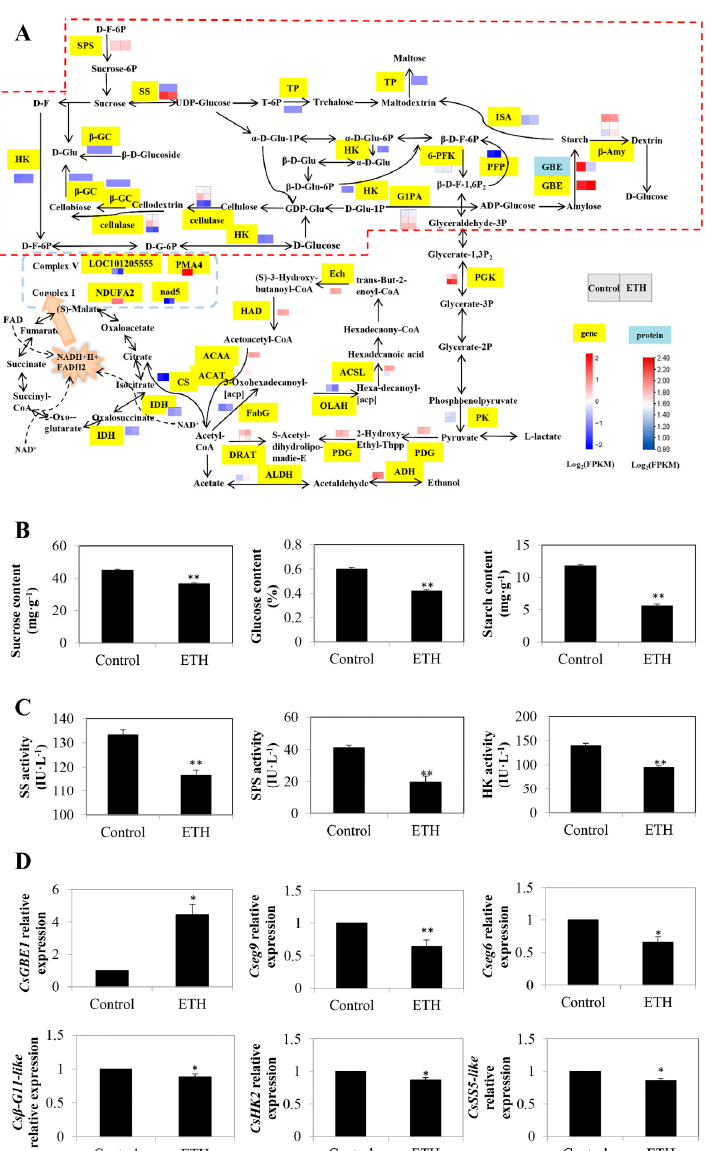
Figure 2. Identification and validation of key DEGs in starch and sucrose metabolism during adventitious root development in cucumber. ( A ) Expression patterns of genes and proteins for starch and sucrose metabolism in carbon metabolism during adventitious root development in cucumber. The dashed box represents starch and sucrose metabolism. Annotations of genes and proteins are available in Supplementary Table S5. Black characters with yellow background are genes, whereas black characters with blue background are proteins. The two squares under the names of genes or proteins indicate the abundance change between the control and ETH. A red square means up- regulation, whereas a blue square means down-regulation. ( B ) The contents of sucrose, glucose and starch during adventitious root development in cucumber. ( C ) The activities of SS, SPS and HK enzyme during adventitious root development in cucumber. ( D ) Quantitative real-time PCR analysis of the expression profiles of 6 genes related to starch and sucrose metabolism during adventitious root development in cucumber. Asterisk (*) and double asterisk (**) indicate the significance at p < 0.05 and p < 0.01, respectively. The bar represents the value of standard error. Values represent the mean ± SE of three replicates. Each experiment was repeated three times